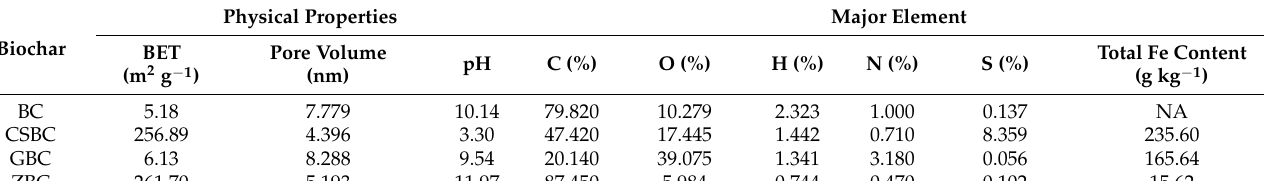
Table 1. Physicochemical properties of BC, GBC, CSBC, and ZBC.